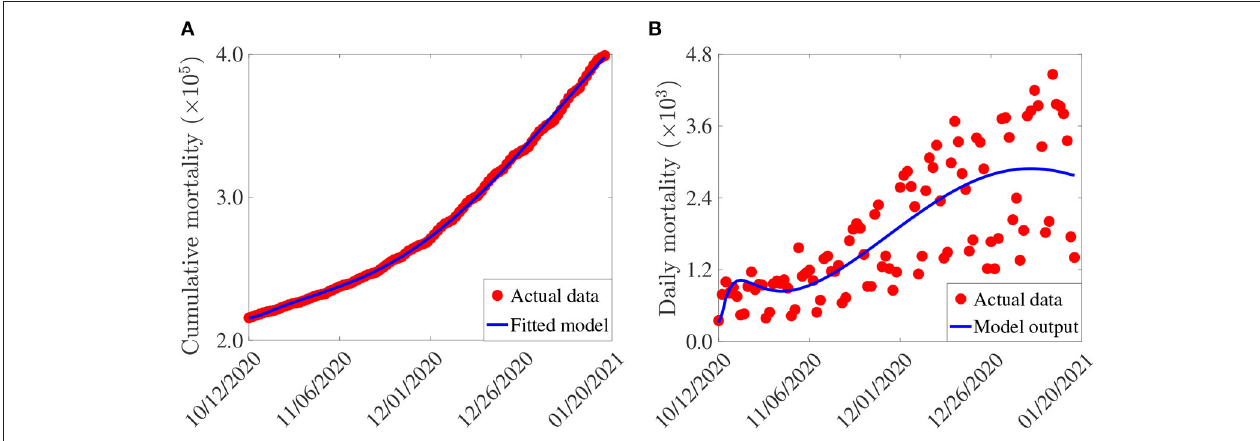
FIGURE 2 | (A) Observed cumulative mortality (red dots), and the predicted cumulative mortality (blue curve) for the U.S. generated using the model (2.5)–(2.6) (in the absence of vaccination) for the period from October 12, 2020 to January 20, 2021. (B) Simulations of the model (2.5)–(2.6) (without vaccination) using the estimated (fitted) and fixed parameters tabulated in Tables 3 , 4 , respectively.